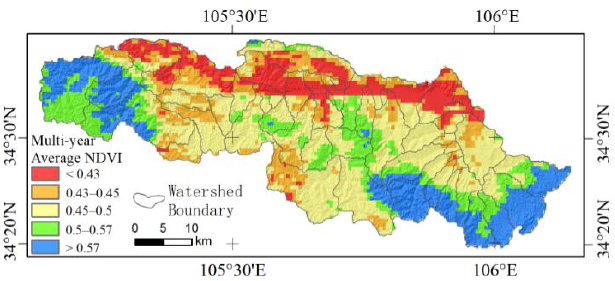
Figure 7. Spatial distribution of multi-year average annual NDVI in Xihe River basin.